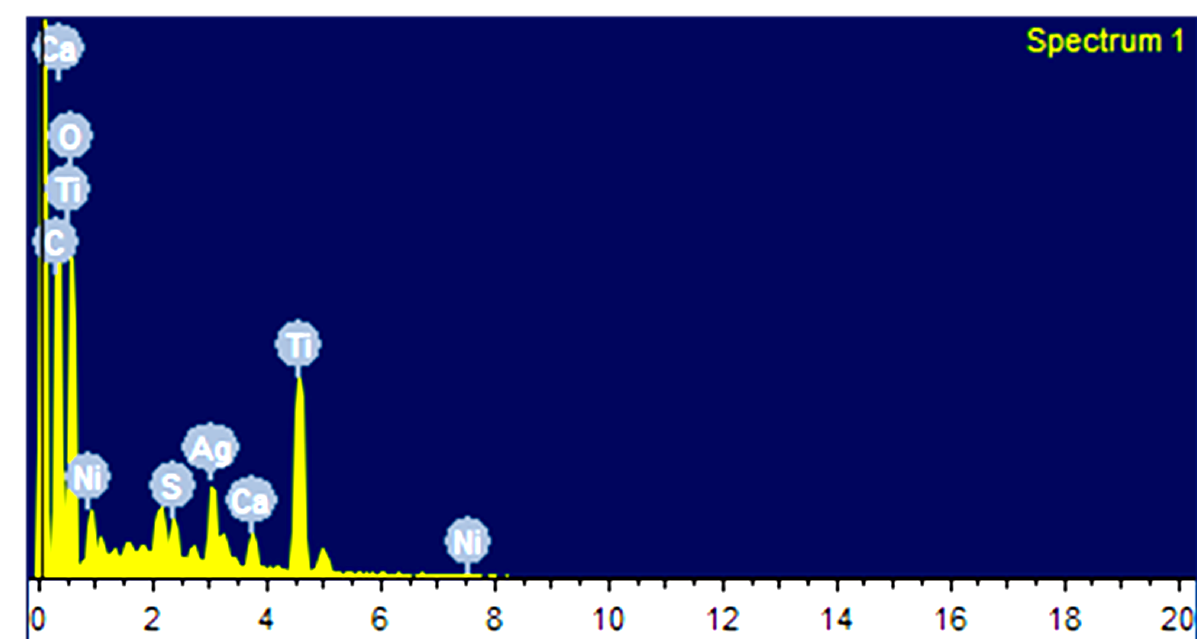
Figure 3. EDAX analysis of Ni 3 S 4 Ag 2 S/TiO 2 /CA.